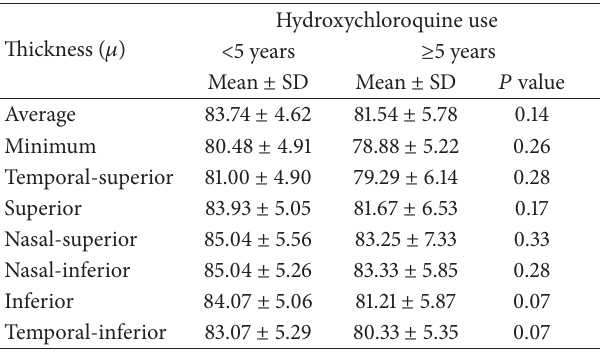
Table 5: Comparison of macular GCIPL thickness in subgroups based on the duration of hydroxychloroquine use.